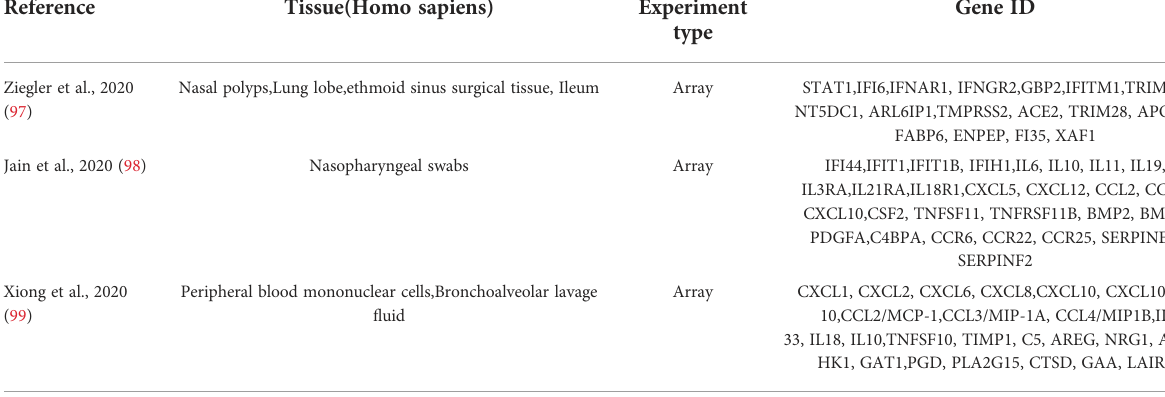
TABLE 4 SARS-CoV-2-associated genes in the relevant